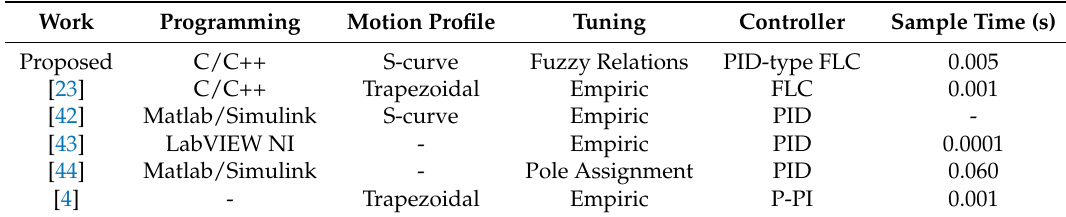
Table 5. Controller motion